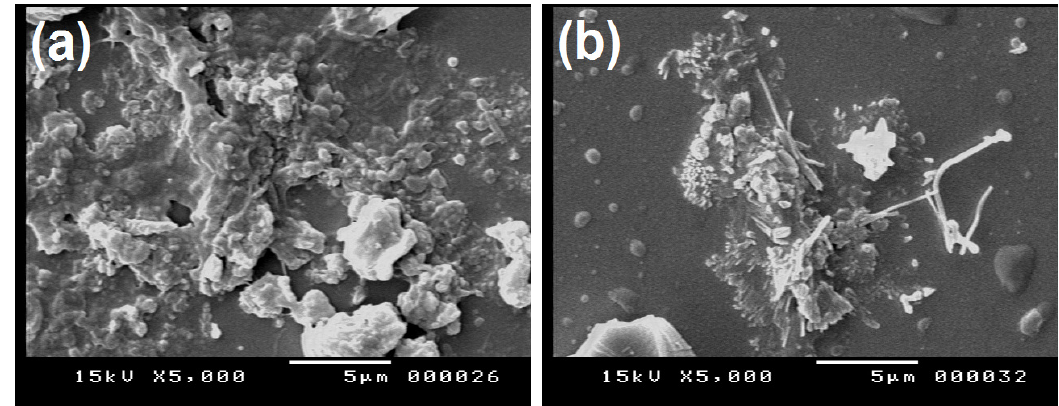
Figure 1. Scanning electron microscope (SEM) images of ( a ) polypyrrole (PPy) and ( b ) polypyrrole-multiwalled carbon nanotubes (PPy-MWCNTs) composite at indium tin oxide (ITO)